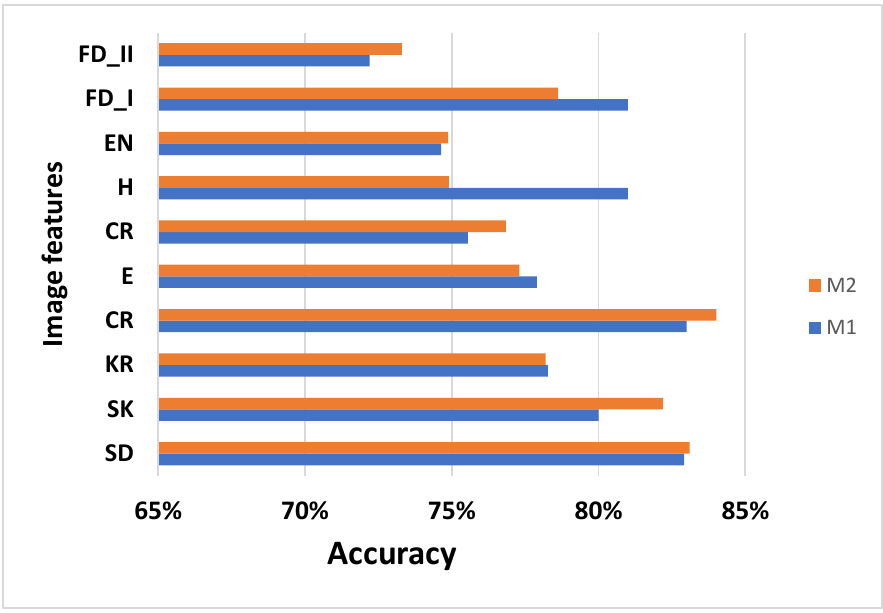
Figure 4. Performances for M1 and M2 methods obtained with K-NN.